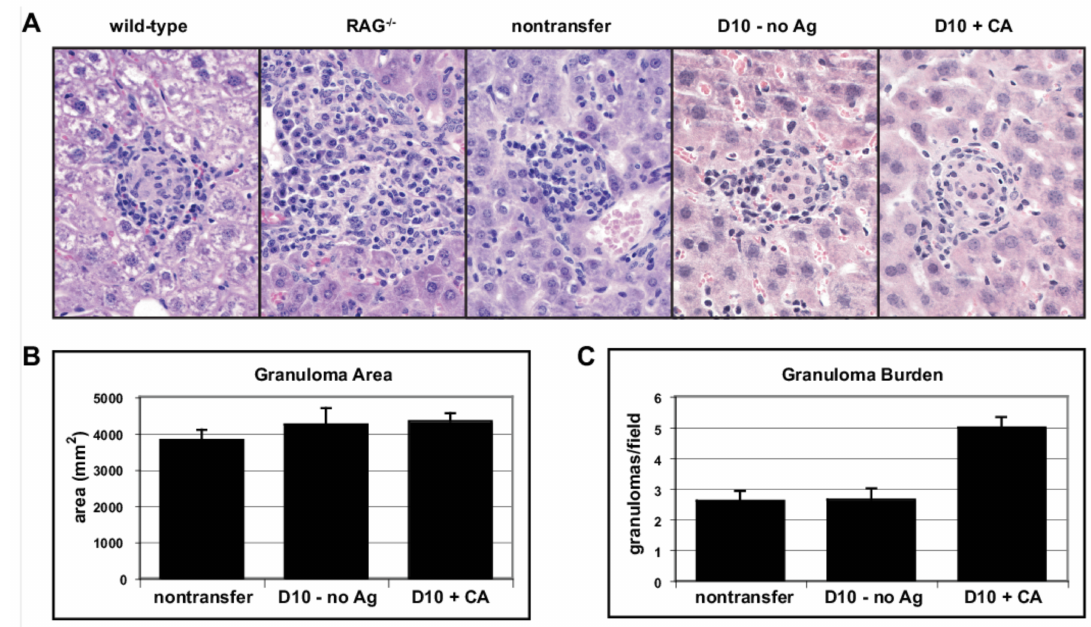
Figure 5. Immunization with CA does not alter granuloma size and structure. ( A ), Formalin fixed liver tissue from BCG-infected C57BL/6, B10.BR RAG − / − , 5CC7 RAG − / − , 5CC7 RAG − / − + D10 T cells, and 5CC7 RAG − / − + D10 T cells + CA (left to right) was embedded in paraffin and sections stained with H&E. ( B ), Digital images were acquired of H&E stained lesions at 400 × total magnification. Lesions were outlined to measure the granuloma area in the Scion Image program (NIH). ( C ), Number of liver granulomas per field at 100 × total magnification was counted. Error bars represent SEM. Data representative of three independent experiments with 2–4 mice per